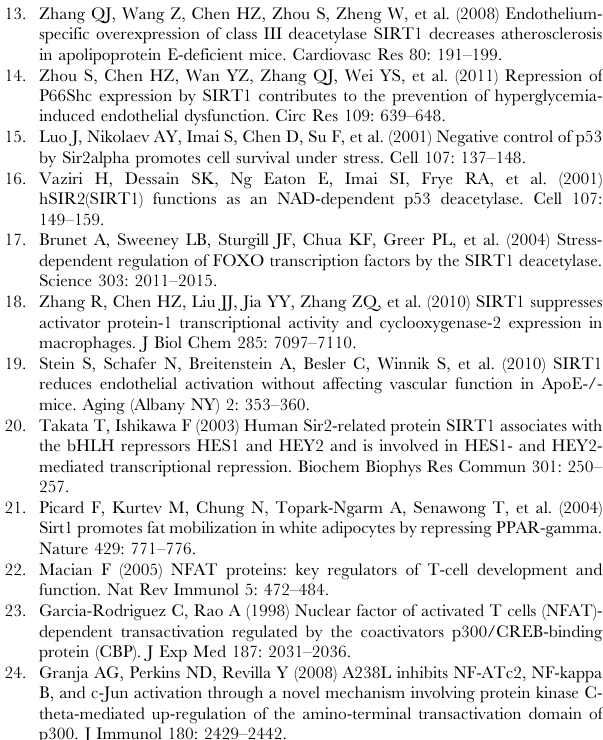
Table S1 PCR primer used for generation of HA-NFAT. (TIF) Table S2 PCR primer used for generation of Myc- NFAT. (TIF) Table S3 PCR primer used for generation of truncated HA-NFATc3. (TIF) Table S4 Real-time PCR primer used for mRNA expression of COX-2 and b -Actin. (TIF) Table S5 Real-time primer used for ChIP on COX-2 promoter or 3 9 -UTR.